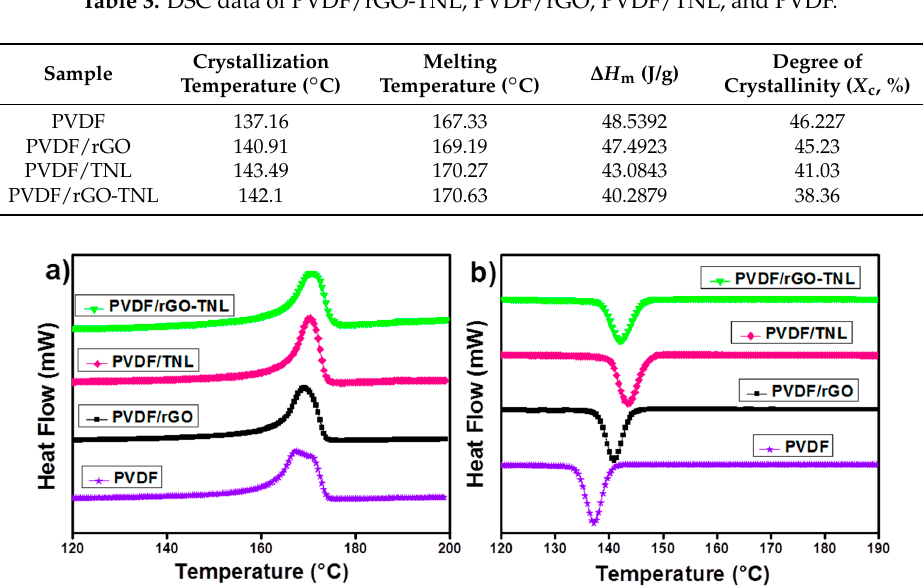
Figure 13. DSC analysis for PVDF and its nanocomposites: ( a ) Melting curve; and ( b ) Crystallization curves.